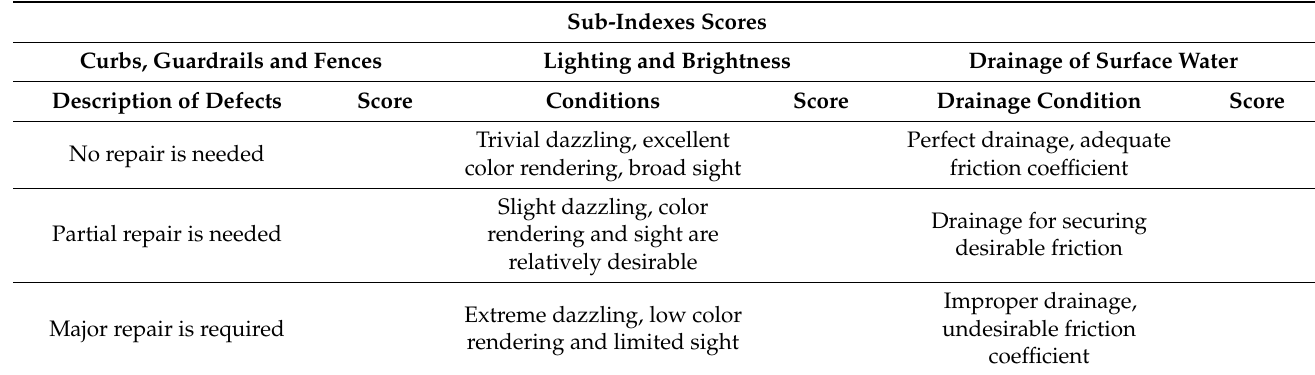
Table A5. Scores of sub-indexes in Safety